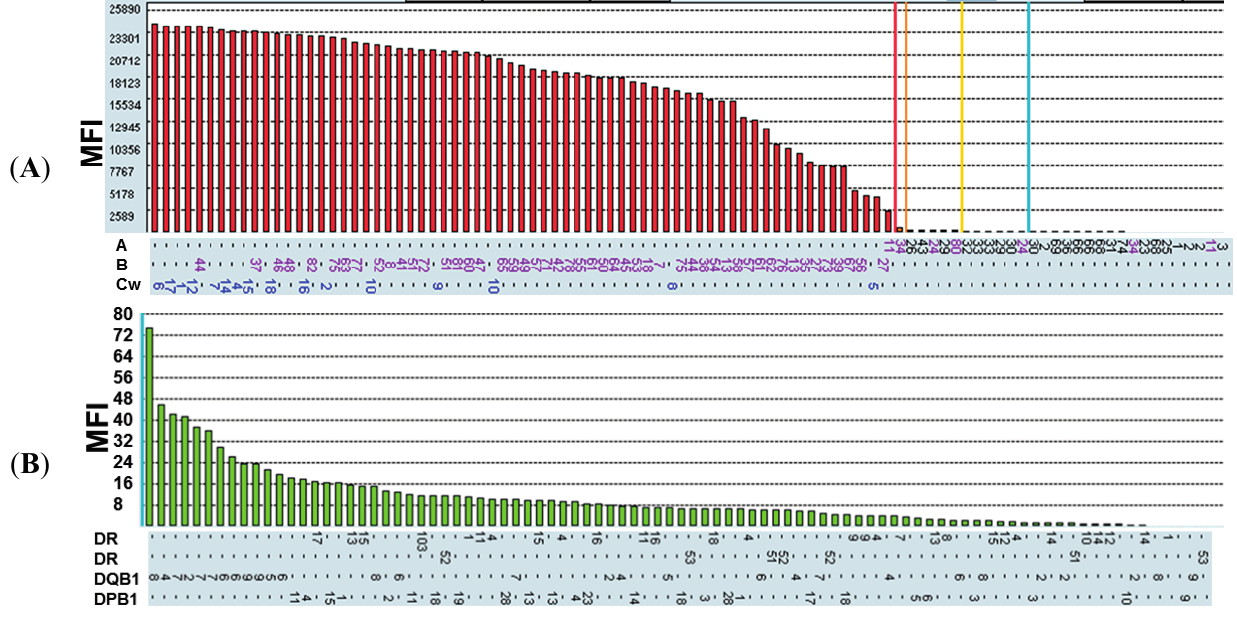
Figure 1. Characterization of binding specificity for BH2 by human leukocytic antigen (HLA)-typing. ( A ) Analysis of BH2 binding to major histocompatibility complex (MHC) class I molecules by using the Luminex Technology. MFI represents mean fluorescence intensity. Cut-off values of mean fluorescence intensity (MFI) for positive binding were set at 637; ( B ) Analysis of BH2 binding to MHC class II molecules by using the Luminex Technology. Cut-off values of MFI for positive binding were set at